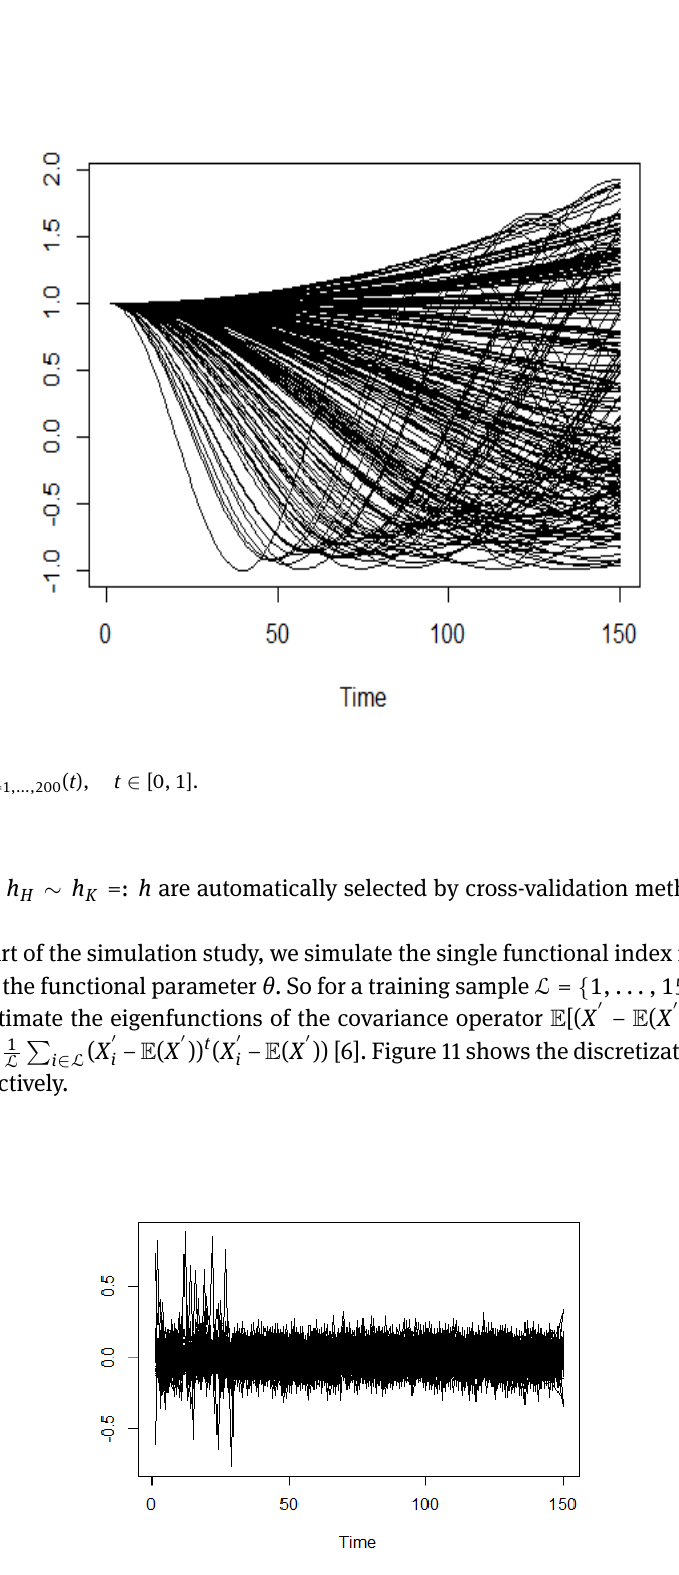
Figure 11: The curves θ i =1, ... ,150 ( t ), t ∈ [0,